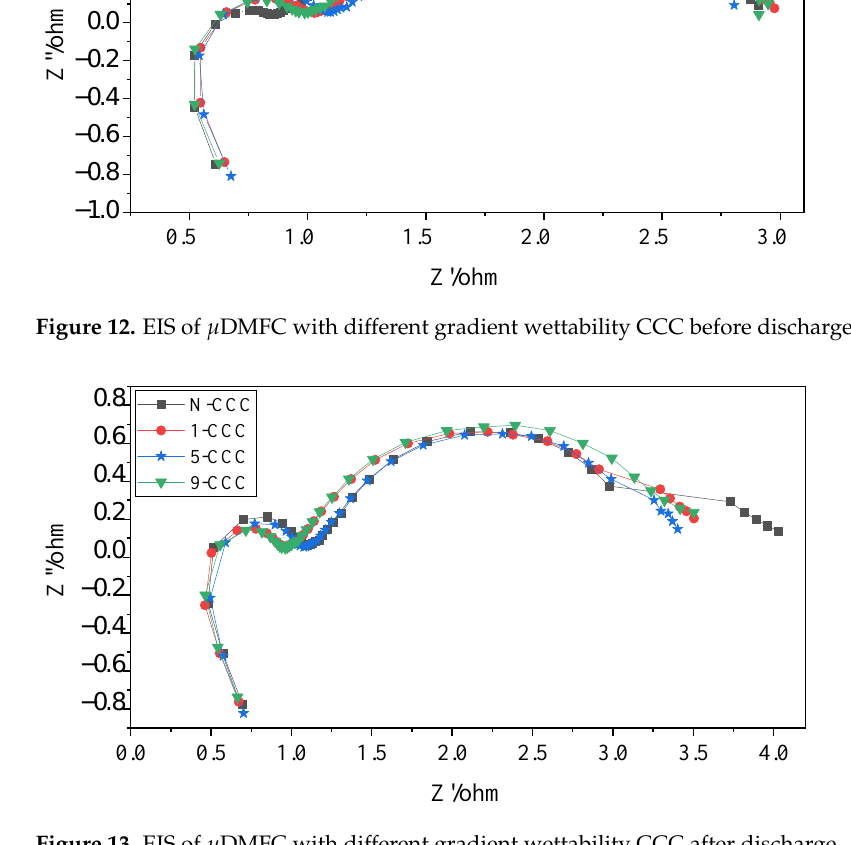
Figure 13. EIS of µ DMFC with different gradient wettability CCC after